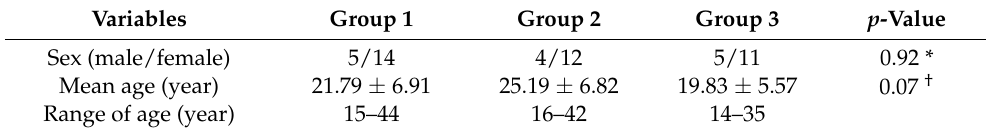
Table 1. Demographic features of the subjects.